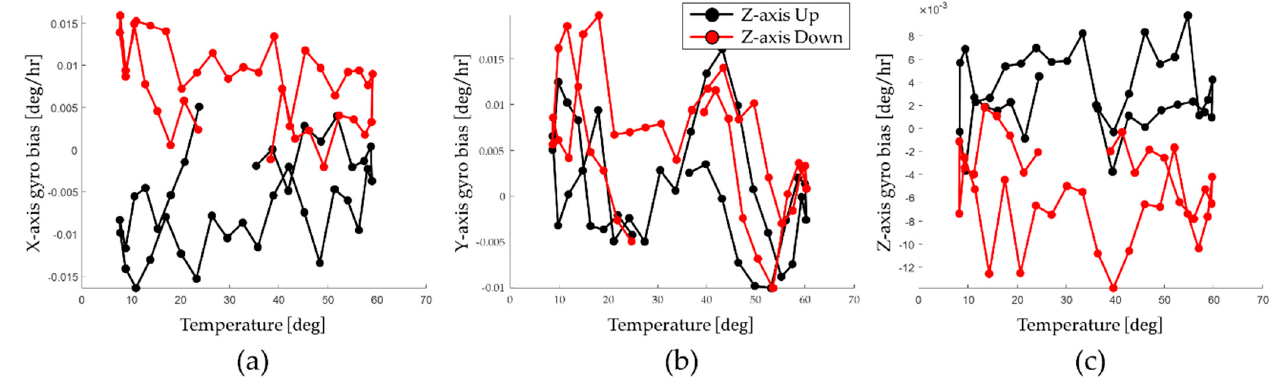
Figure 8. Identified gyro bias according to the position; ( a ) X − axis; ( b ) Y − axis; ( c ) Z − axis.